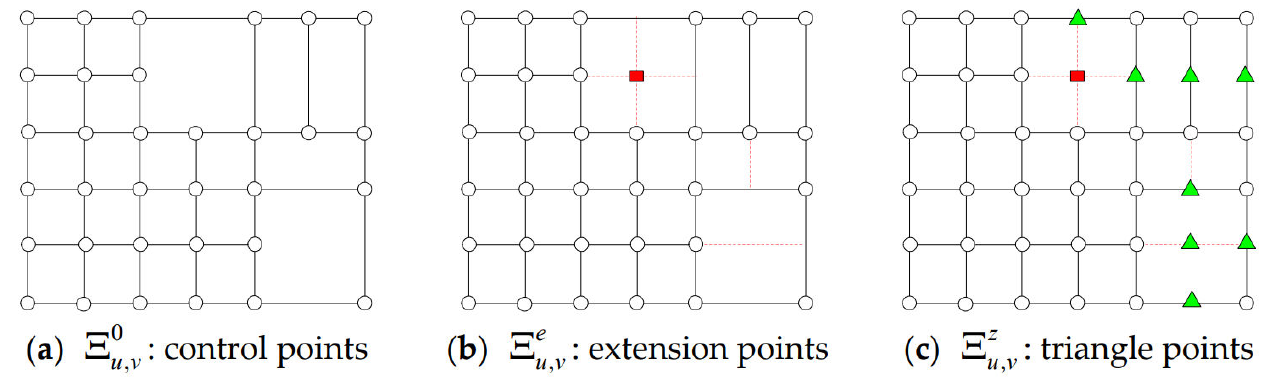
∗ , v ∗ ) ( u ∗ , v ∗ ) × Ξ 0, ( u u v